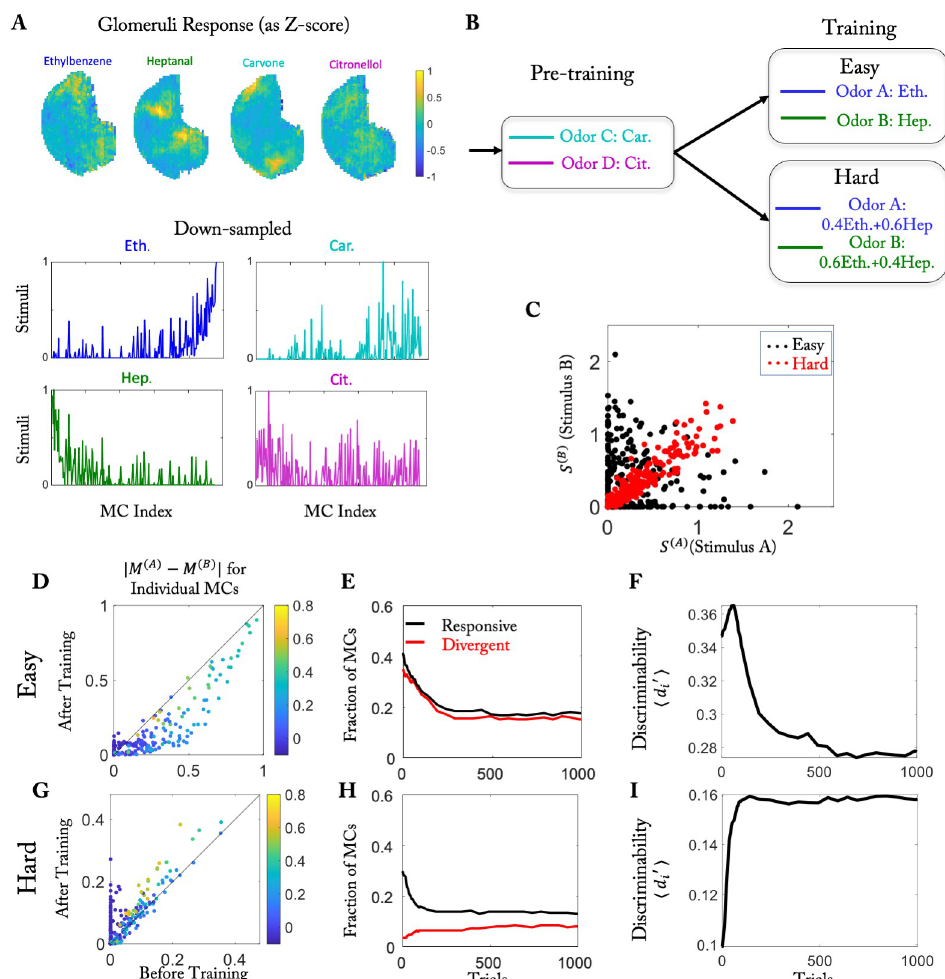
Fig 2. Easy and hard discrimination task using naturalistic stimuli. (A) Odors employed in the training. Top: Glomerular activation patterns (cf. [39]). Bottom: Activation patterns down-sampled to 240 points, serving as stimuli S ( i ) . MCs are sorted based on the difference in activation by the stimuli of odor pair 1. (B) Computational protocol. (C) Activity of each MC for the two stimuli used in the easy (black) and hard (red) task. (D, G) Difference in the response to the two stimuli for each MC before and after training for the easy and the hard task, respectively. Color of the dots represents the mean response | M (1) + M (2) − 2 M ( air ) |/2 before training. (E, H) Temporal evolution of the number of responsive MCs and divergent MCs during the training in the easy task and hard task, respectively (cf. [26]). (F, I) Temporal evolution of h d 0 i for the easy task and the hard task, respectively. Parameters as in Table 1 except for γ = 1.7 � i 10 − 4 . with indices above � 600. Each of these GCs is connected with either the MCs responding to stimulus A (MC indices 60–110) or to stimulus B (MC indices 110–160). Conversely, if two